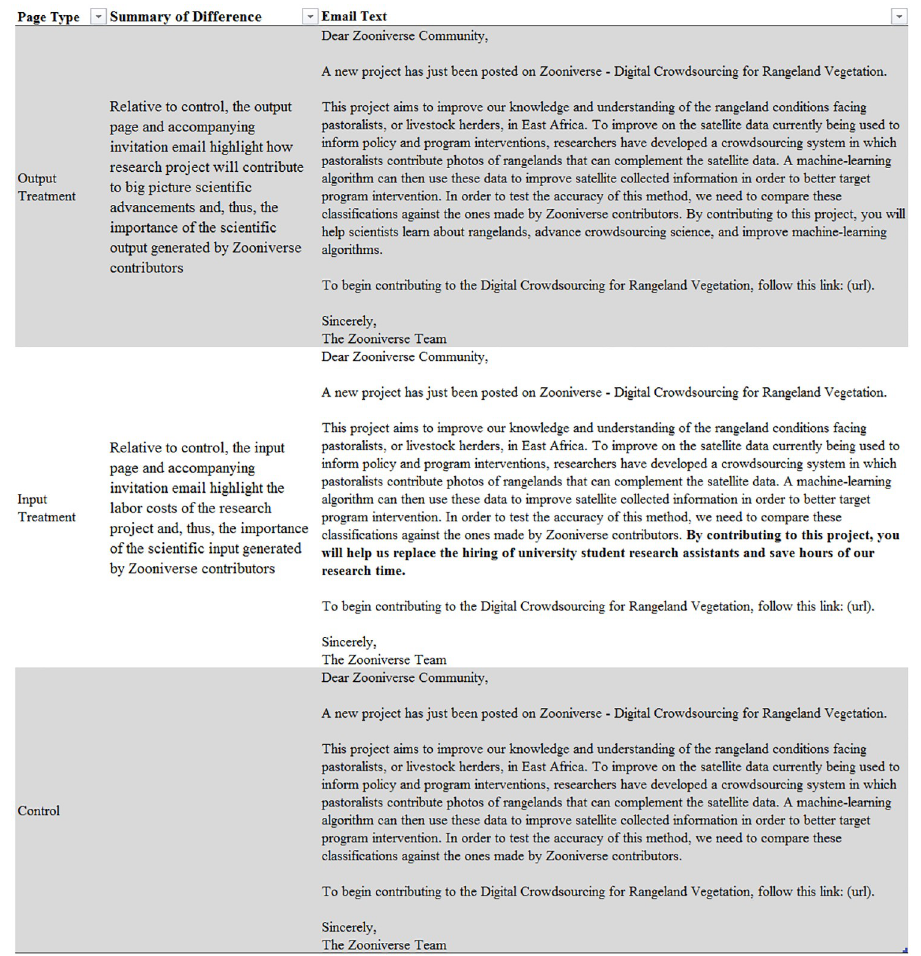
Fig 1. Summary of treatments relative to control. Figure summarizes the differences between the output treatment, the input treatment, and the control. Bold text is text not included in other email scripts. The complete text provided in all three project pages are presented in the text displayed in S2